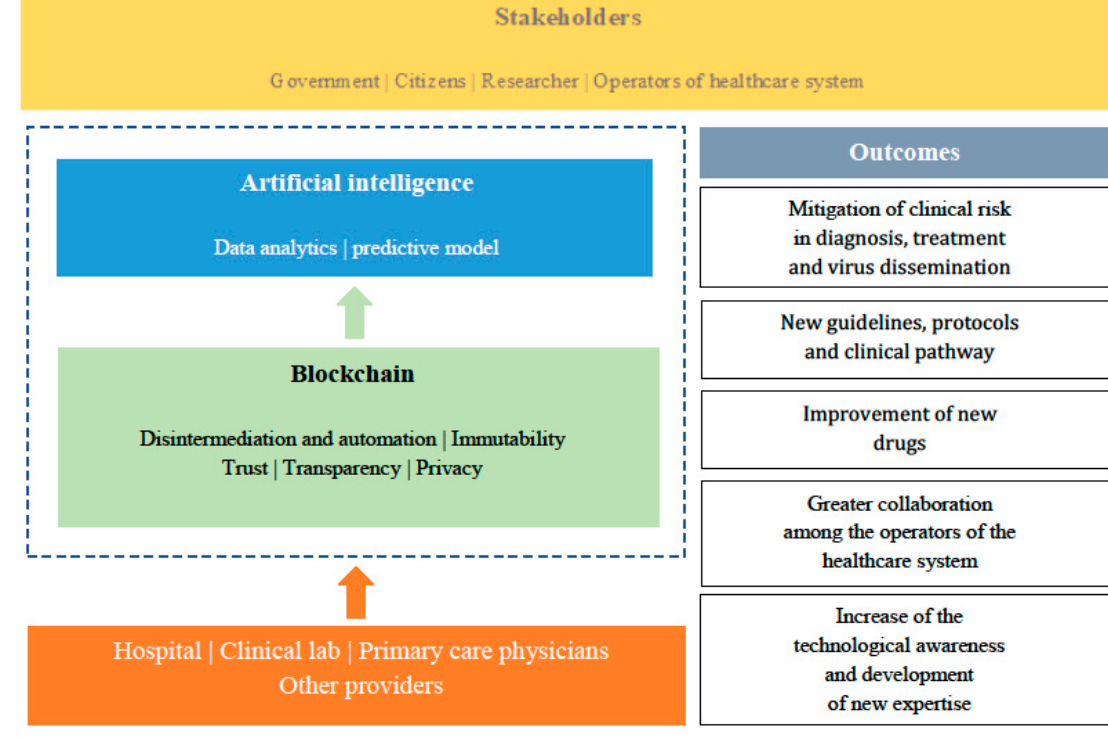
Figure 3. Insights into the main outcomes derived from the blockchain-based model.